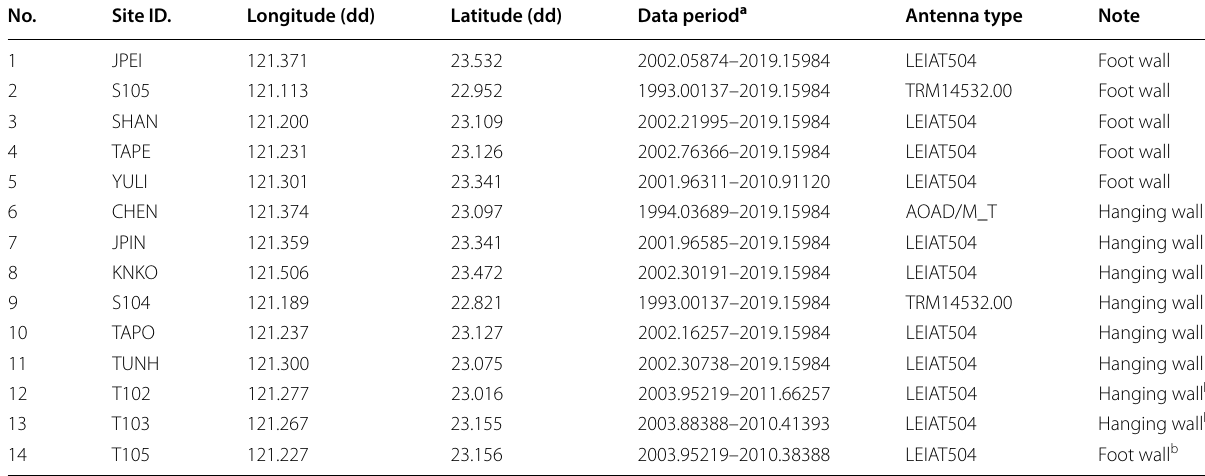
Table 1 Station information and data period